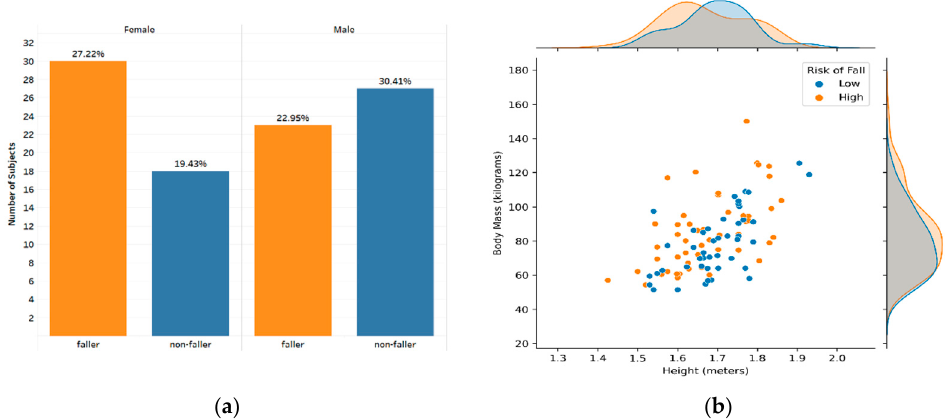
Figure 1. Descriptive summary of geriatrician’s fall classification versus subjects’ gender, height, and weight. ( a ) represents the percentage of fallers and non-fallers in each group of females and males separately; ( b ) shows the joint distribution of fallers and non-fallers with respect to subjects’ height and body mass.